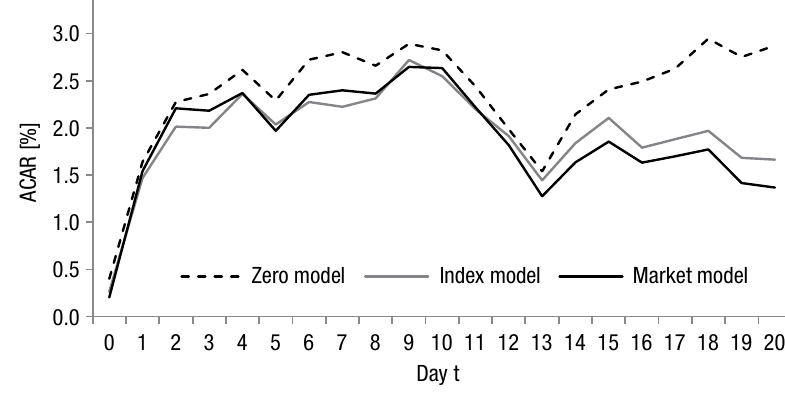
Fig. 1. Short-term abnormal returns on acquiring